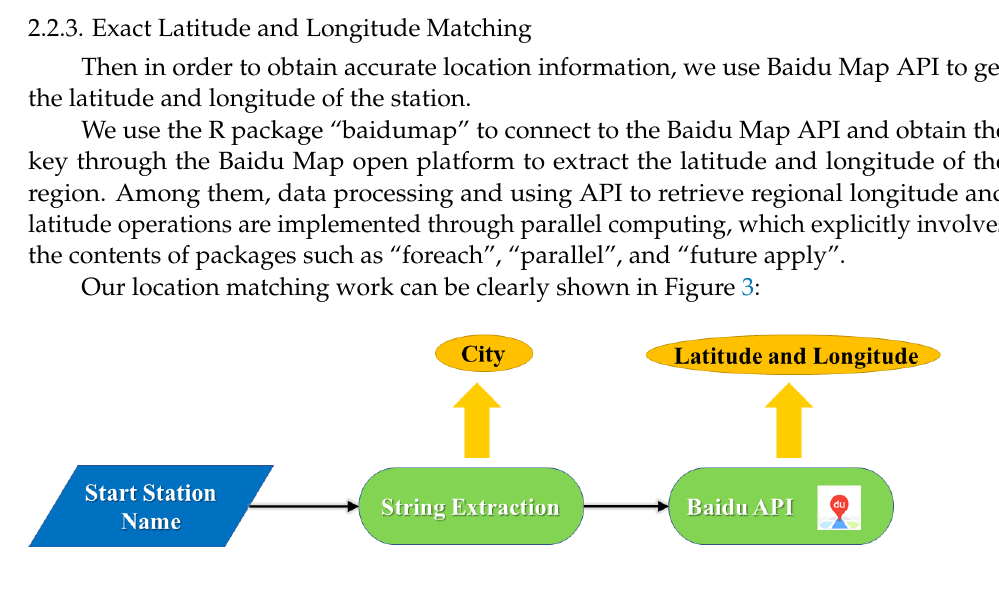
Figure 3. Location matching progress.The main steps are the extraction of cities and the acquisition of latitude and